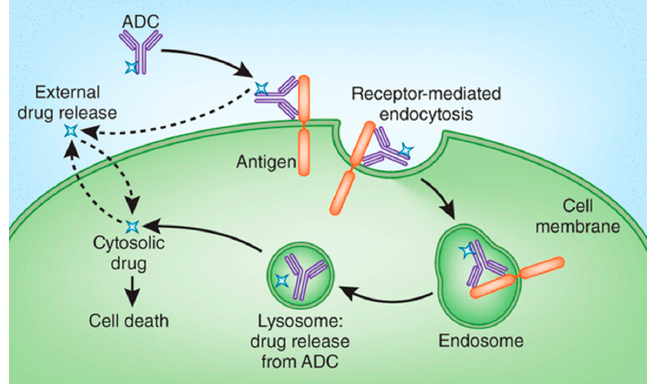
Figure 3. Schematic representation of the mechanism of drug delivery mediated by ADCs. Reproduced with permission from reference [41]. Solid line arrows indicate specific tumor cell killing through receptor-mediated endocytosis. Dash line arrows elicit the specific tumor cell killing through extracellular drug